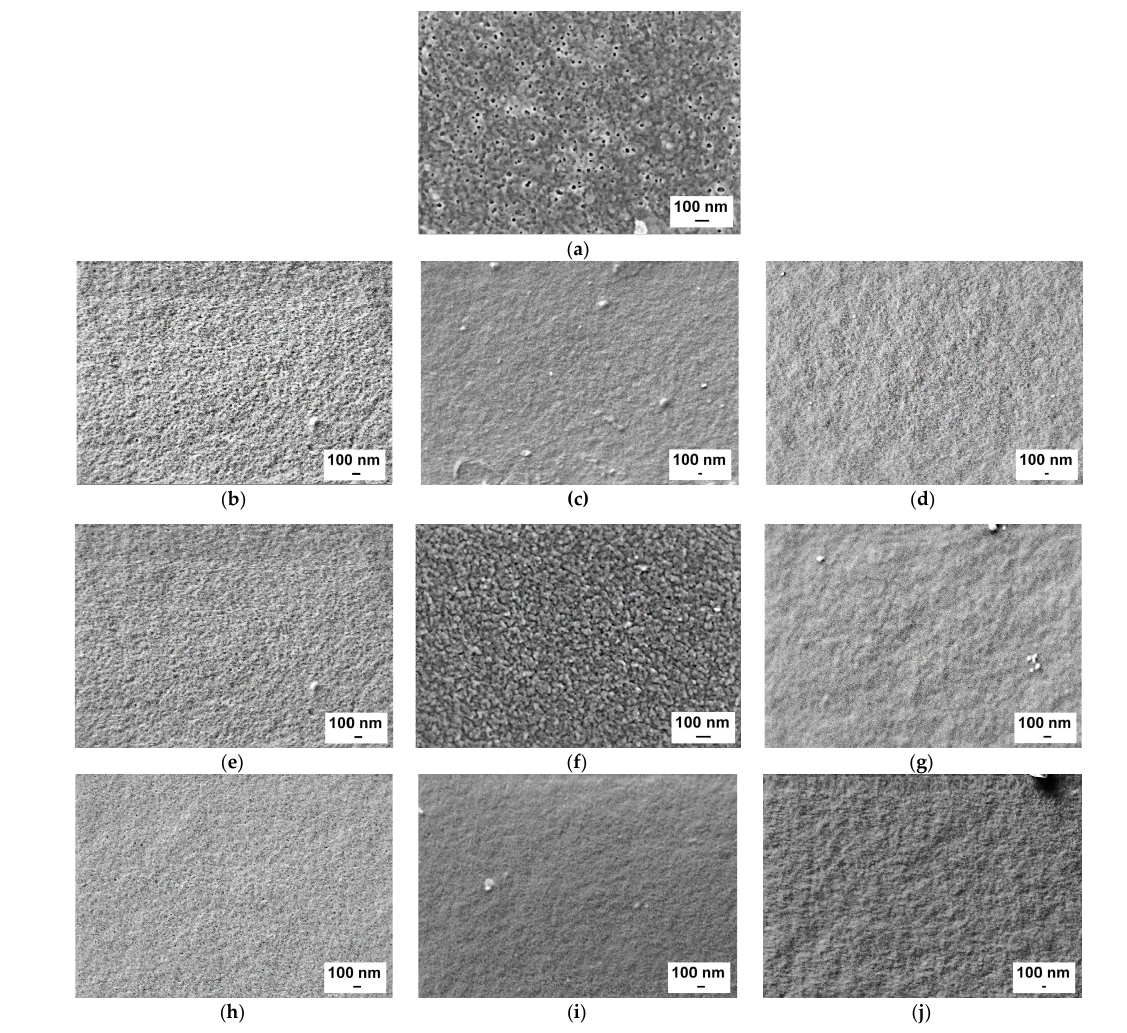
Figure 4. SEM micrographs of the membrane skin layer surfaces: ( a ) PA ‐ 0; ( b ) PA ‐ 100 ‐ 1.0; ( c ) PA ‐ 250 ‐ 1.0; ( d ) PA ‐ 450 ‐ 1.0; ( e ) PA ‐ 100 ‐ 1.5; ( f ) PA ‐ 250 ‐ 1.5; ( g ) PA ‐ 450 ‐ 1.5; ( h ) PA ‐ 100 ‐ 2.0; ( i ) PA ‐ 250 ‐ 2.0; and ( j ) PA ‐ 450 ‐ 2.0.